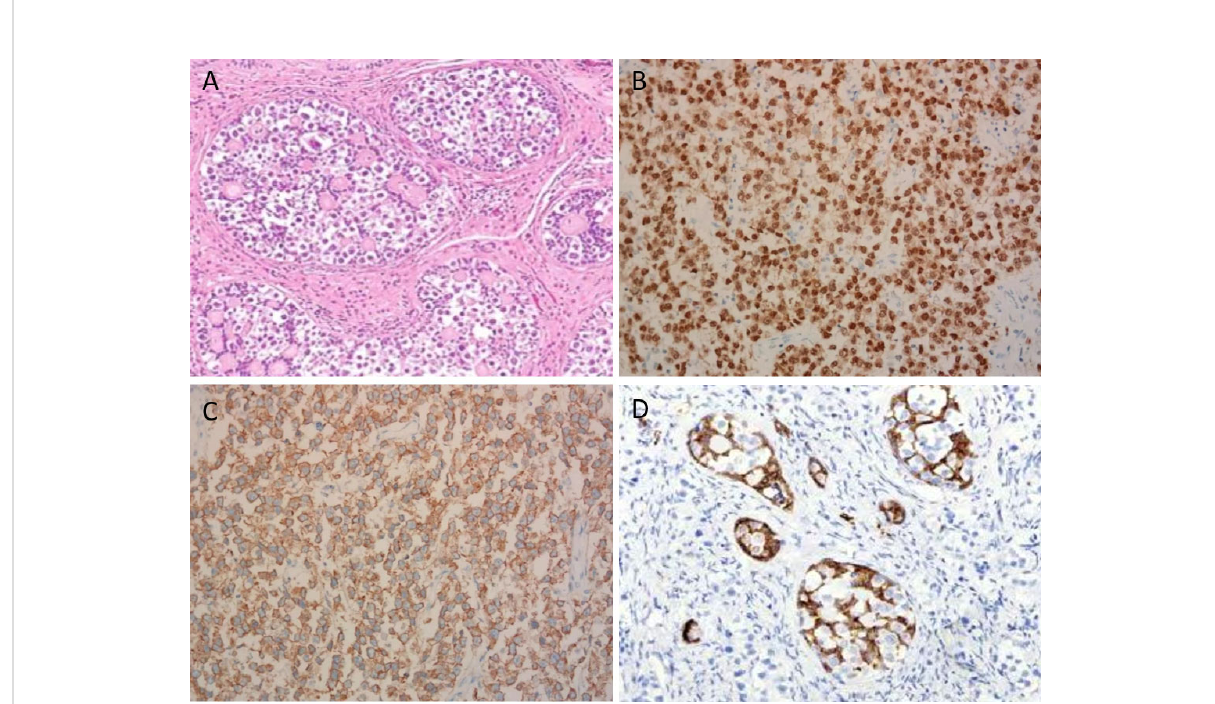
FIGURE 1 Microscopic view of the ovarian gonadoblastoma with coexisting dysgerminoma (×200). (A) A mixture of germ cells, elements of the sex cord, and hyaline bodies were placed in large nests and lobes. (B) Dysgerminoma component demonstrating positive nuclear staining for OCT4. (C) Dysgerminoma component demonstrating positive membranous staining for CD117. (D) Sex cord component demonstrating positive cytoplasmic staining for a